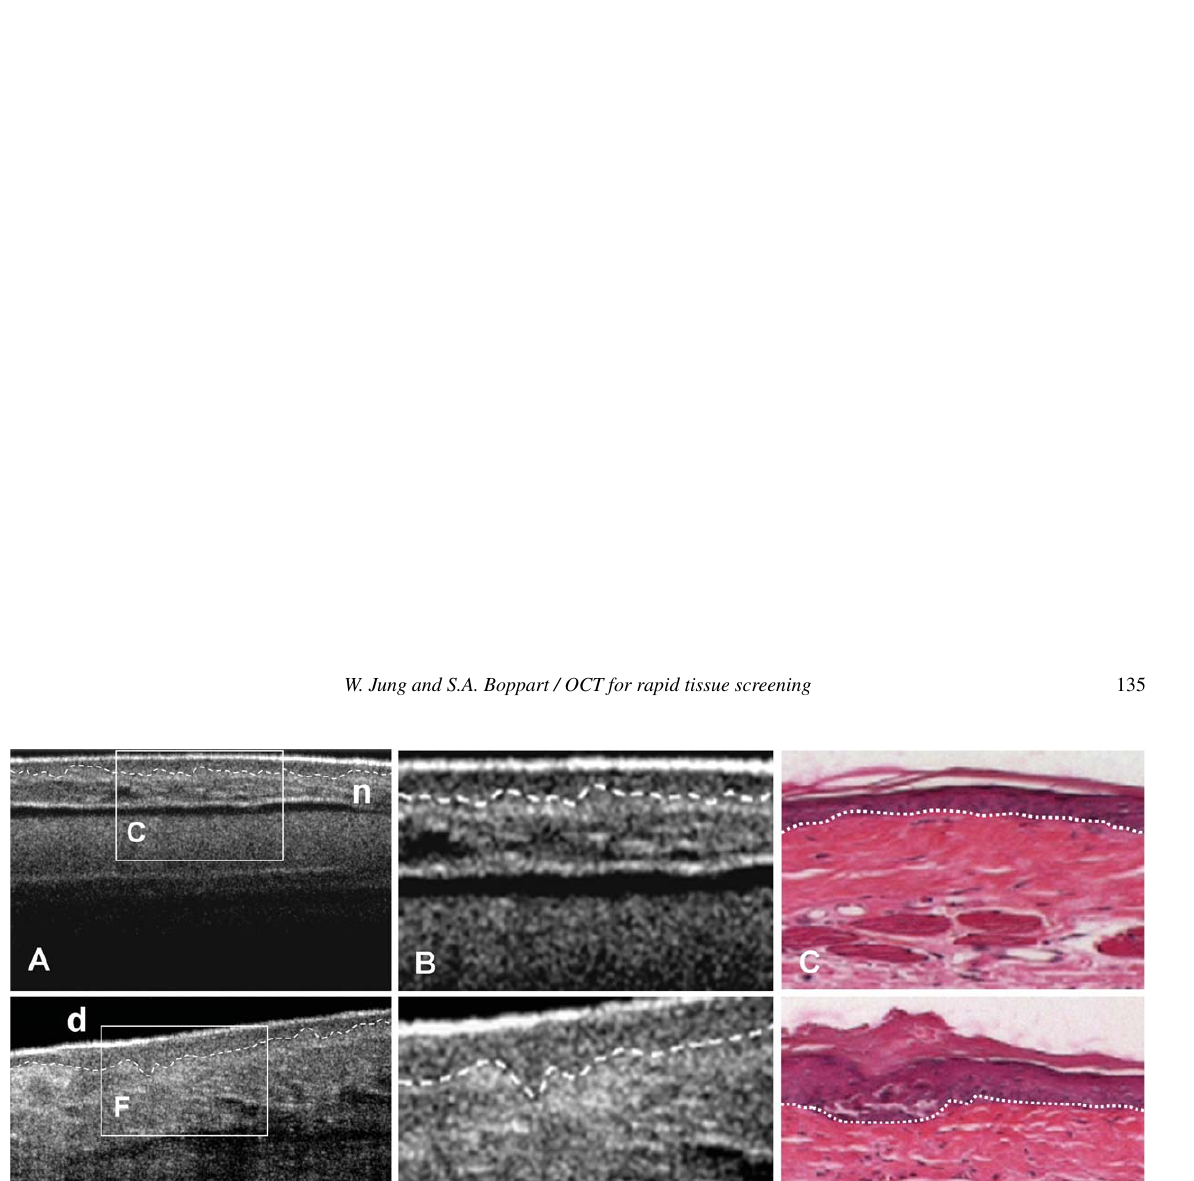
in imaging regions that are difficult to access